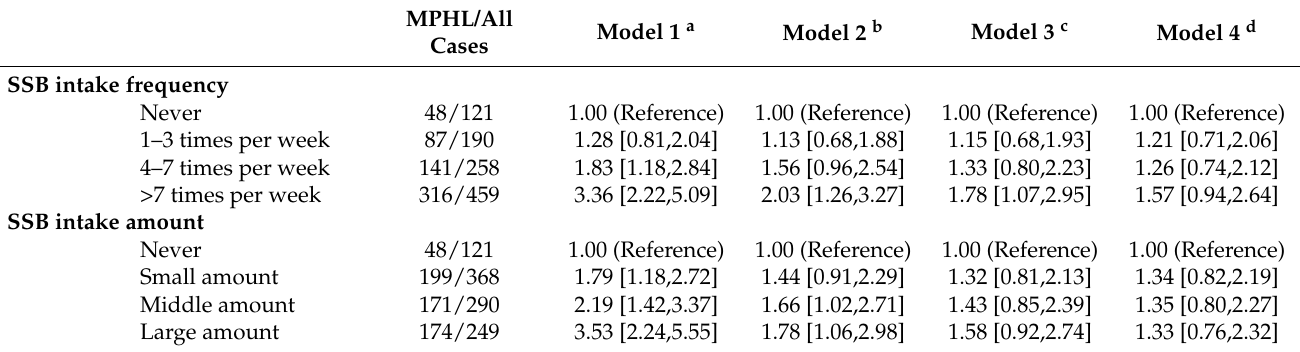
Table 4. Odds ratio and 95% confidence interval of MPHL among different SSB